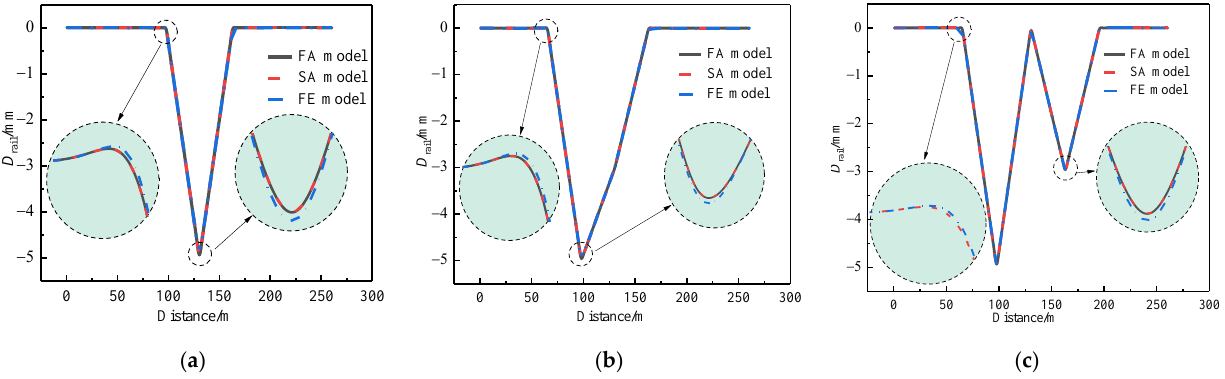
Figure 6. Mapping deformation of the rail with the pier settlement. ( a ) The #3 pier settlement; ( b ) #2 and #3 pier settlement; and ( c ) the #2 and #4 pier settlement.